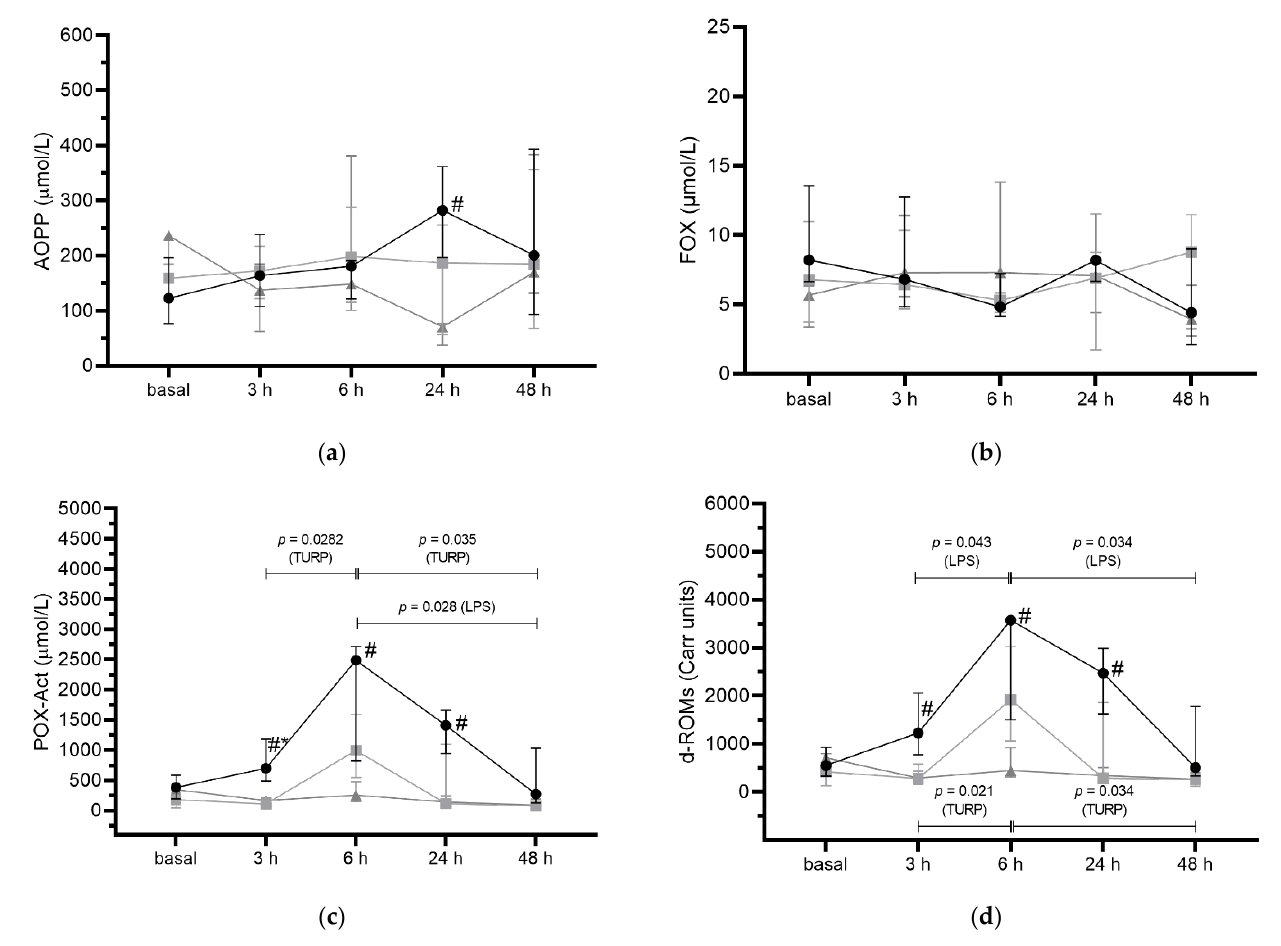
Figure 2. Salivary ( a ) advanced oxidation protein products (AOPP), ( b ) ferrous oxidation-xylenol orange (FOX), ( c ) peroxide activity (POX-Act), and ( d ) reactive-oxygen-derived compounds (d- ROMs) concentrations in control ( ▲ ), lipopolysaccharide (LPS)-treated pigs ( ● ), and turpentine (TURP)-treated pigs ( ■ ) before (basal) and after 3 h, 6 h, 24 h, and 48 h the inoculations. The results are presented as median with an interquartile range. # , significantly different from the control group; * , significantly different from TURP-treated pigs ( p < 0.05; one-way ANOVA with Sidak ’ s multiple comparisons test). Differences between times are indicated by bars and the obtained p - value (one- way ANOVA with Tukey’s multiple comparison test).